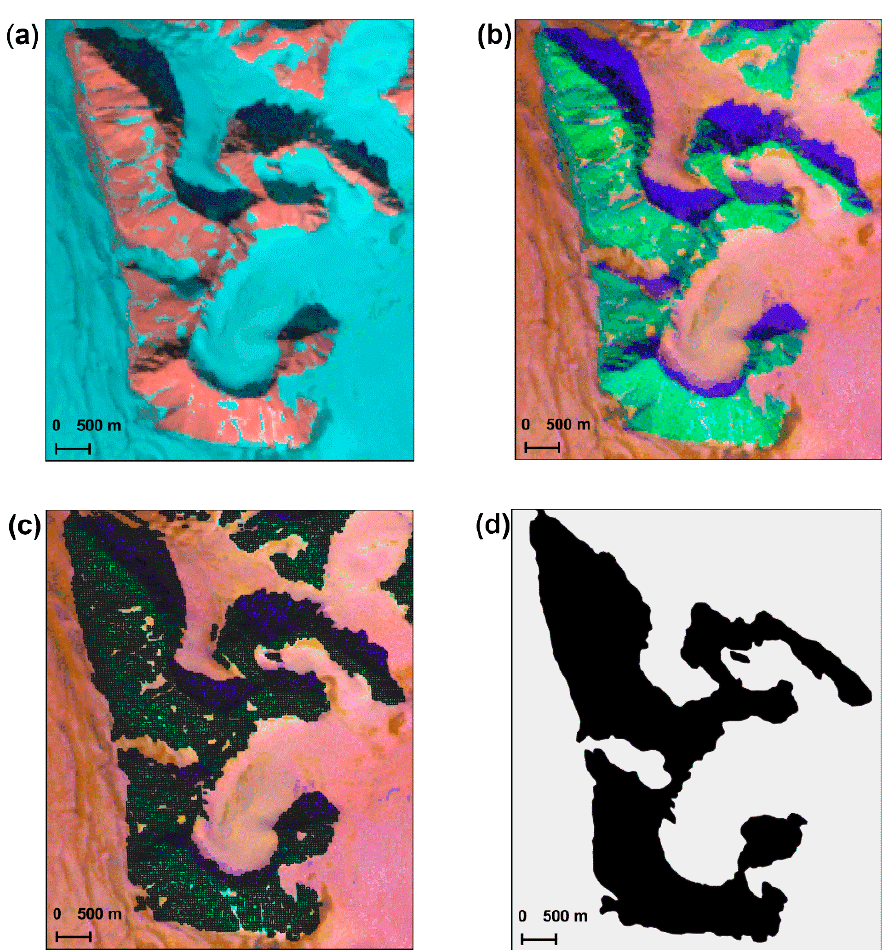
Figure 3. Identification of the glacier-nunatak border based on a Landsat satellite image (background based on the Landsat 5 scene ID: LT52170031986220KIS00, 8.08.1986, National Aeronautics and Space Administration (NASA) and U.S. Geological Survey (USGS)): ( a ) colour composition image based on the Landsat 5 TM 543 channels (and 654 for Landsat 8 OLI / TIRS) created using ArcGIS; ( b )